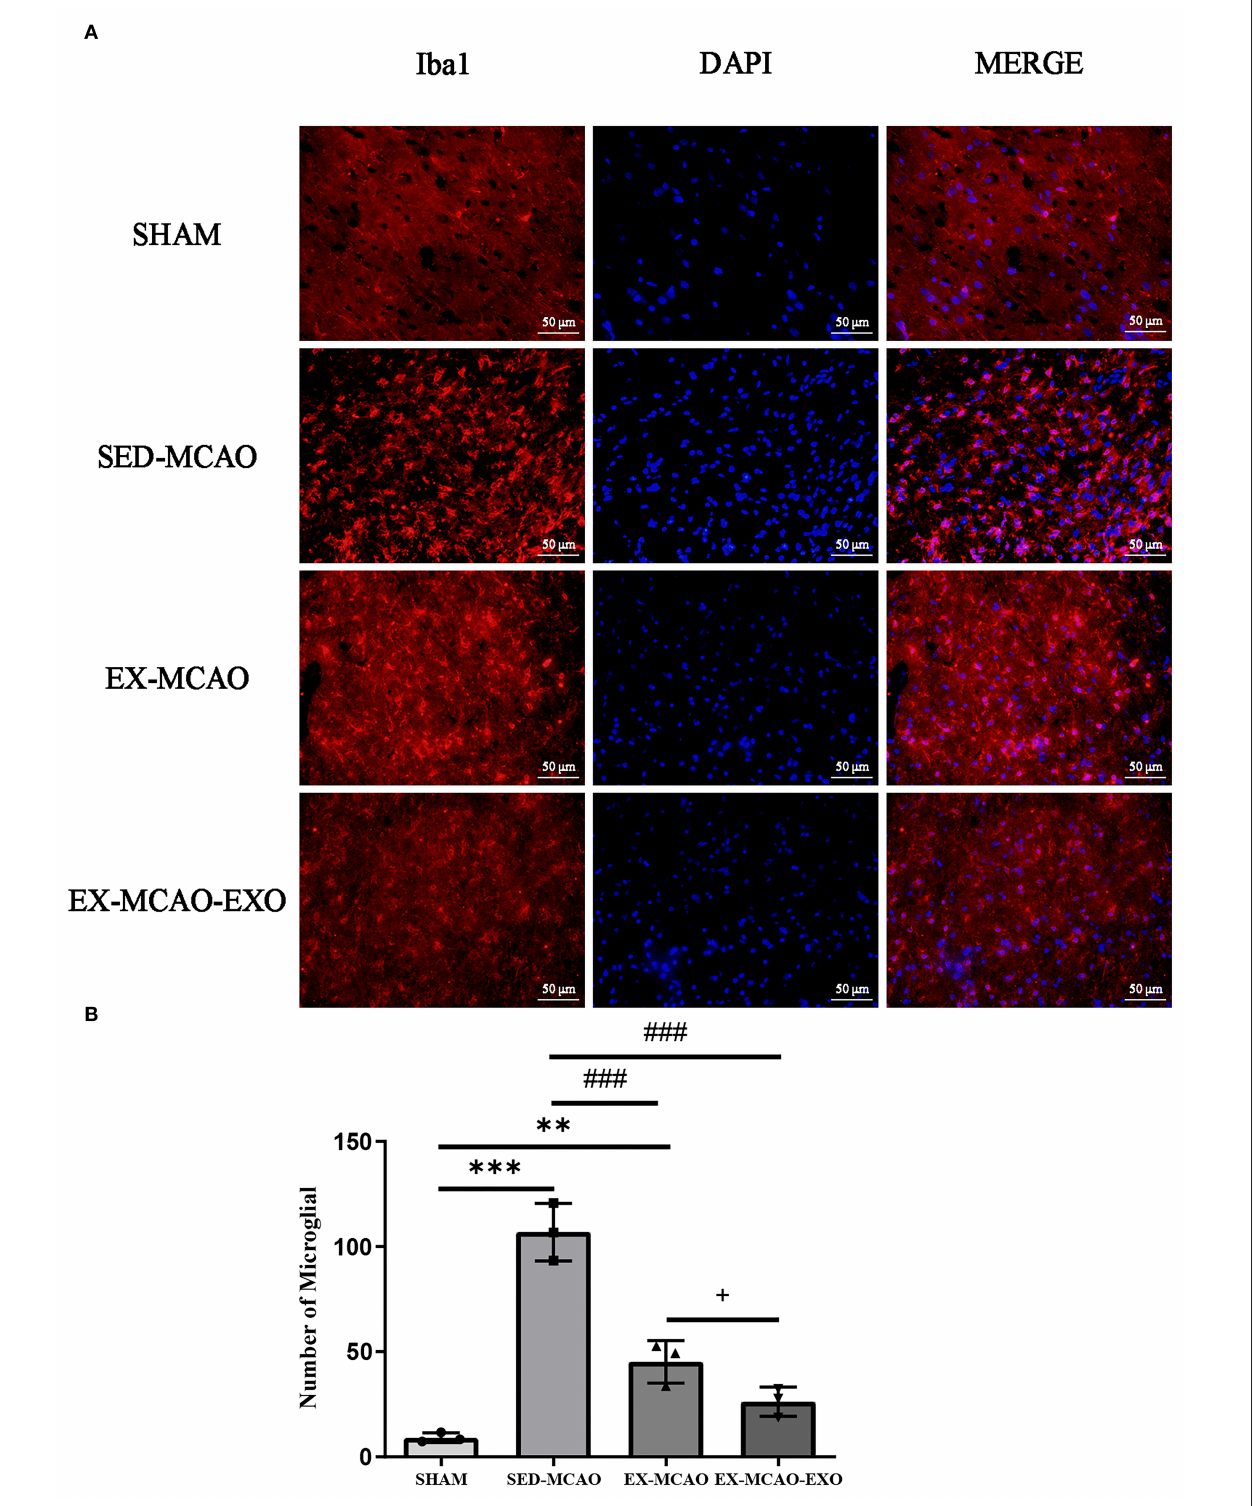
FIGURE 4 | (A) Representative immunofluorescence images of Iba1 staining. Bar = 50 µ m. (B) Number of microglia. ** P < 0.01 and *** P < 0.001 compared with the SHAM group; ### P < 0.001 compared with the SED-MCAO group; + P < 0.05 compared with the EX-MCAO group. Mean ± standard deviation. N = 3/group.